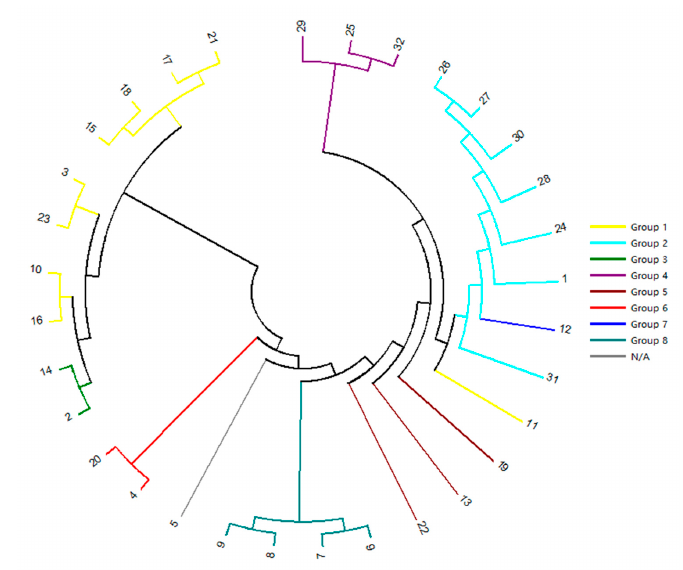
Figure 7. Results of PCR products obtained with the SSR marker ZJULM 50 on 6% denaturing polyacrylamide gel at 60 mA constant current (Nos. 1–32, 32 accessions, detailed explanation can be seen in Table 6; DNA Marker: DL2000).